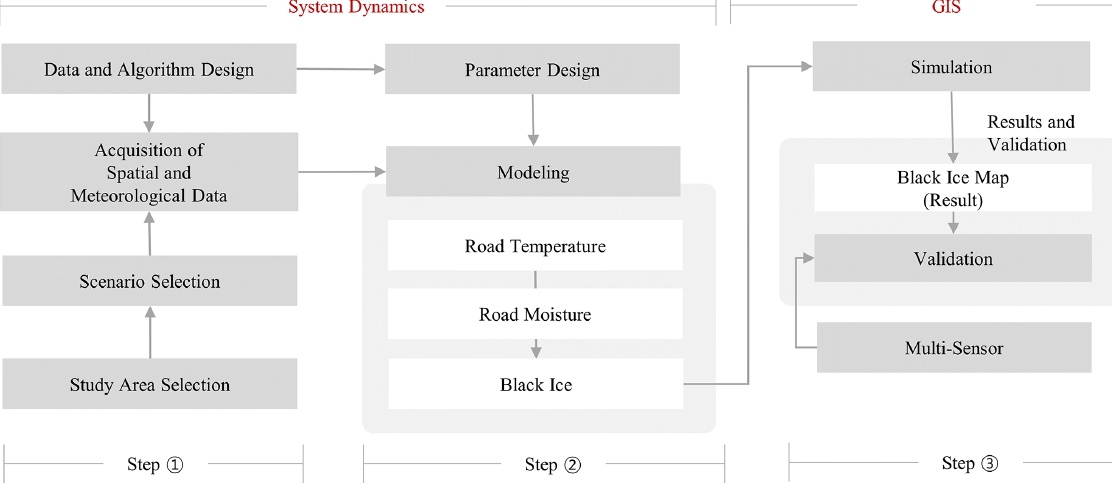
Figure 1. Summary of black ice modelling and sensor validation studies.